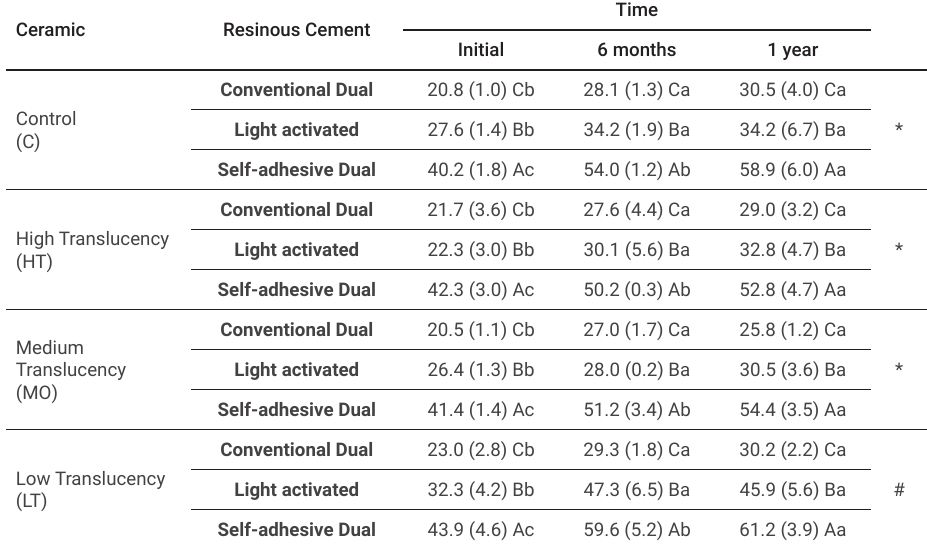
Table 2. Mean (standard deviation) of water sorption data in experimental groups